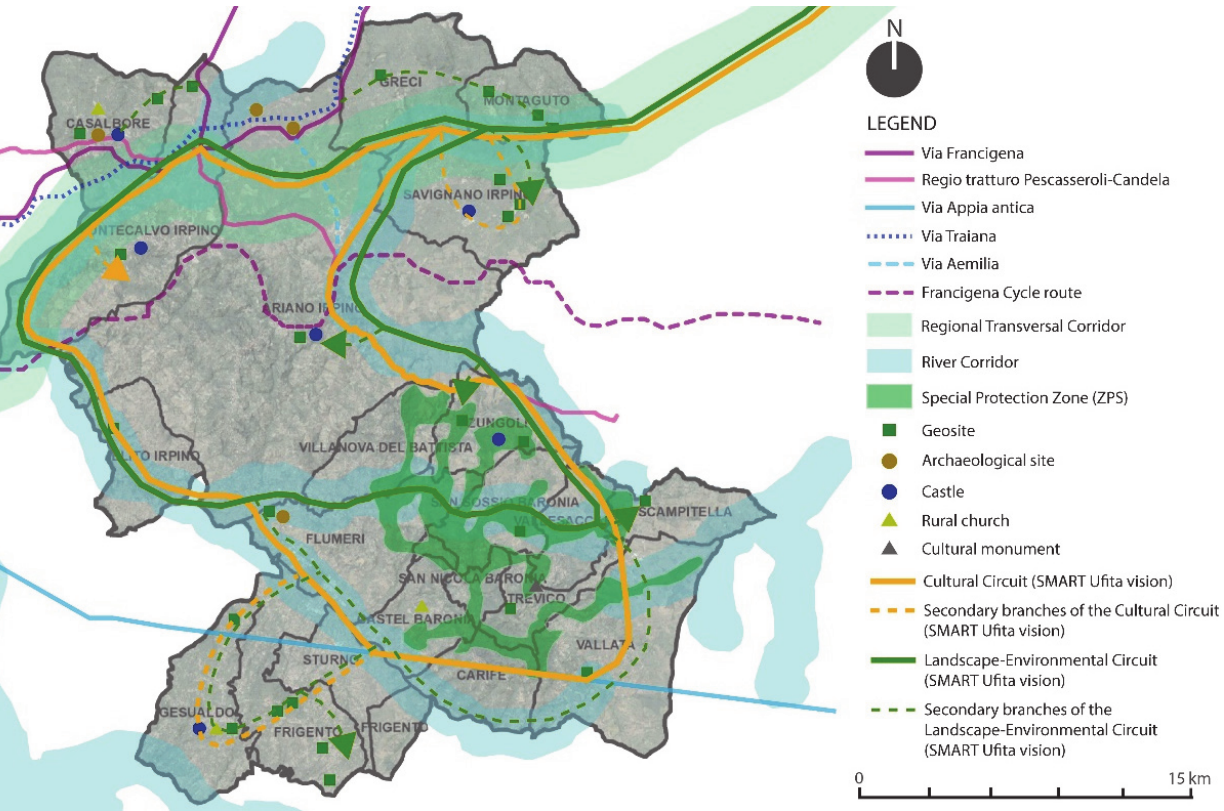
Figure 9. Area strategy for the “Historical, cultural and environmental heritage” axis © Figure RI.P.R.O.VA.RE Project (DICIV research unit).